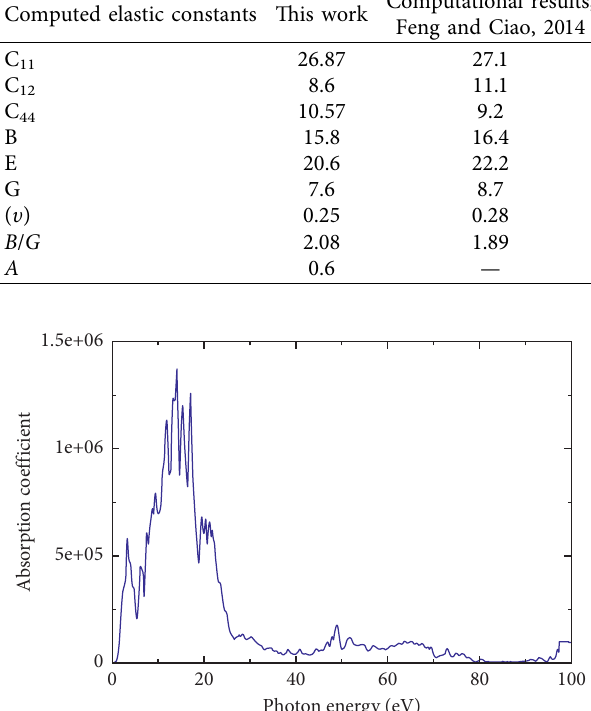
Table 1: Computed elastic constants such as C modulus ( B ), shear modulus ( G ), B / G ratio, Young’s modulus ( E ), Poisson’s ratio ( υ ), and anisotropy factor ( A ).